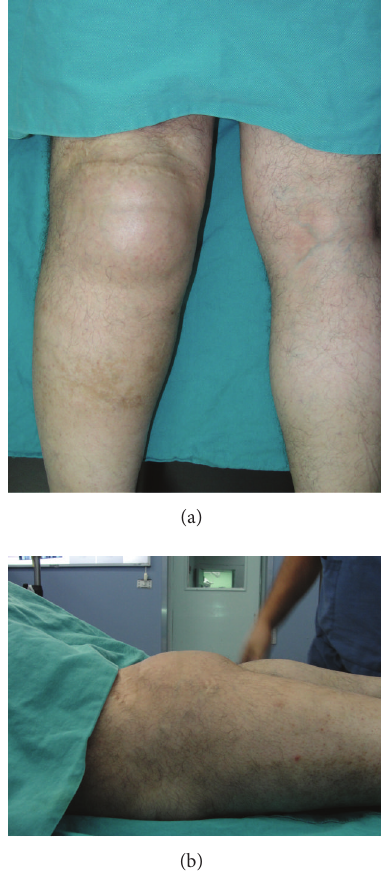
Figure 2: The posterior and lateral view of the popliteal mass on the operating table.